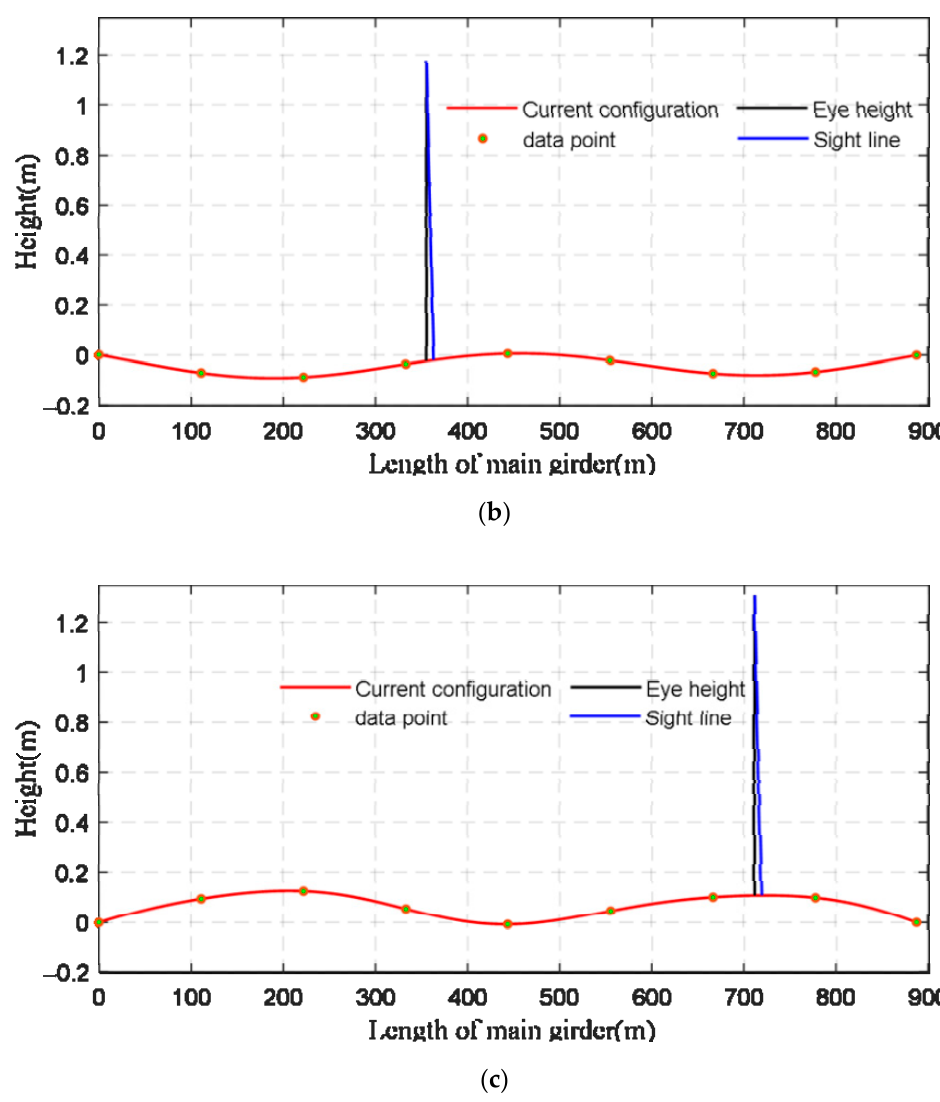
Figure 13. The car’s driving front blind area at three different moments under VVIV ( : dynamic configurations of VVIV; : the eye height; : the tangent line between eye and car’s front cover). Tangent line intersects the configuration at a point, and the length of front blind area is the distance from the intersection point to car’s head. ( a ) t = 1.6 s, online perception of the front blind area. ( b ) t = 16 s, online perception of the front blind area. ( c ) t = 32 s, online perception of the front blind area.